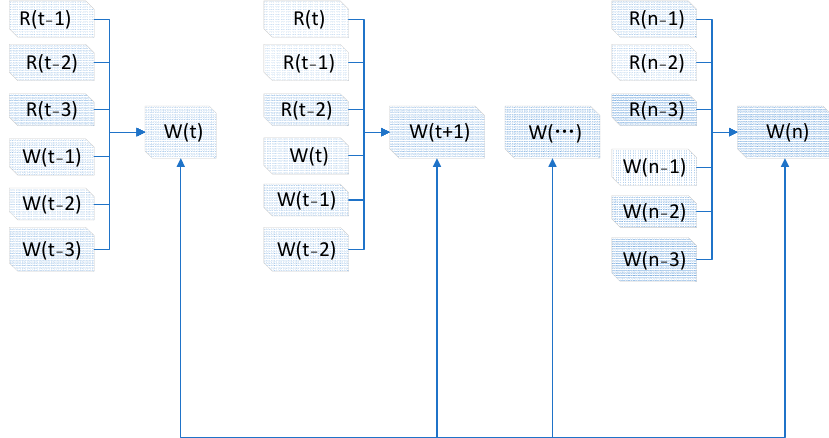
Figure 10. Factors related to prediction of ponding.